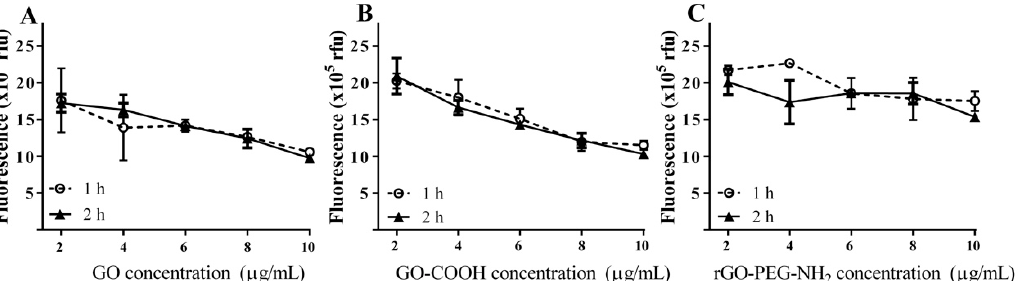
Figure 3. The effect of ultrasound treatment time on different species and concentrations of graphenic nanomaterial for FAM-DNA fluorescence quenching. ( A ) Graphene oxide, ( B ) carboxyl graphene oxide, ( C ) reduced graphene oxide amino-PEG covalently linked. Concentrations: graphenic materials (2–10 μ g/mL), FAM-DNA probe (100 nM).